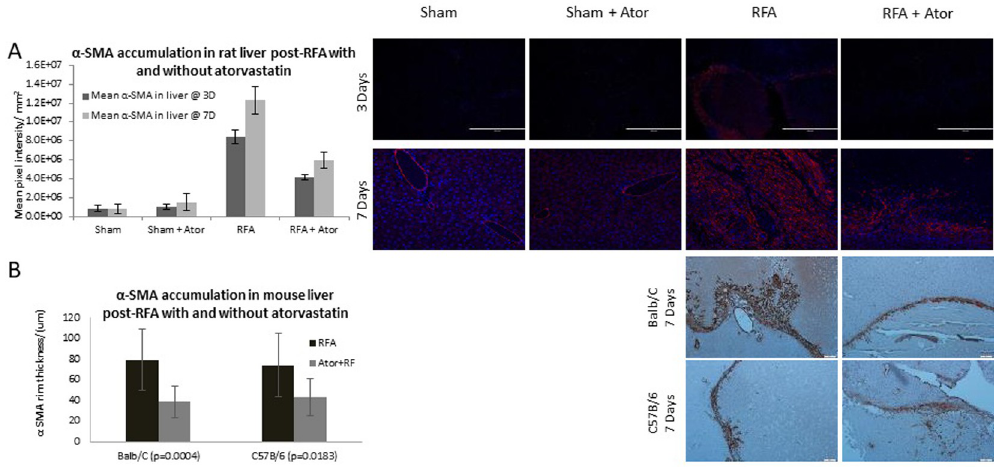
Fig 1. Atorvastatin reduces RFA-induced myofibroblast periablational infiltration in treated liver in three rodent models. Animal livers were evaluated using immunofluorescent staining. Statistically significant increased immunofluorescent intensity of infiltrating α -SMA positive cells was detected in the RFA treatment group as compared to sham or sham plus atorvastatin. Atorvastatin treatment significantly reduced α -SMA cell positivity at 3 and 7 days post- treatment (p-value < 0.001, both comparisons), while remaining elevated to control groups at both time points (p-value < 0.001) (A). Immunohistochemical analysis of BALB/c and C57B/6 mice (B) livers 7 days after RF ablation with and without atorvastatin treatment likewise demonstrated significant reduction of α -SMA periablational rim thickness in the combined RFA and atorvastatin group in both models (p-value < 0.001 and p-value < 0.05, respectively).